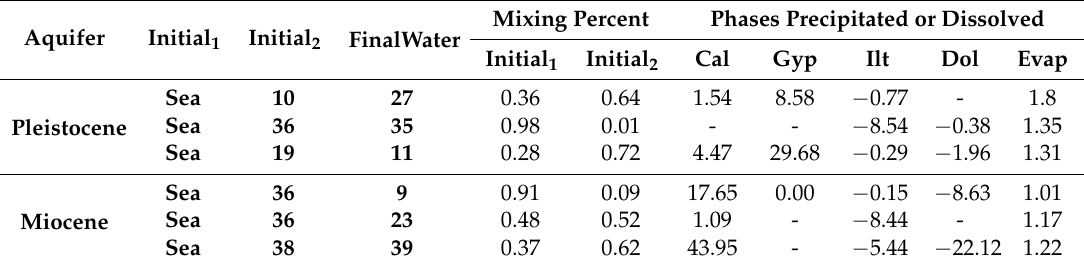
Table 4. NETPATH seawater mixing model results (mmol/L) representing groundwater Group II. Aquifer